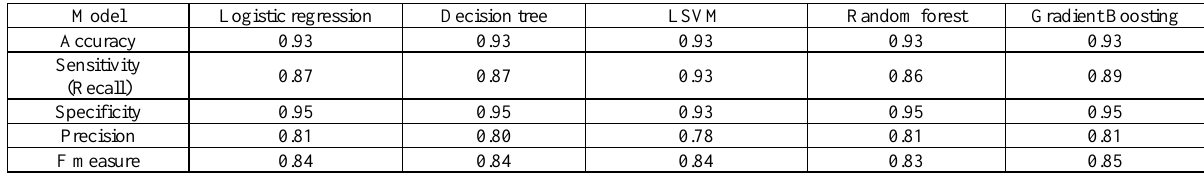
Table 2. Performance measures of the